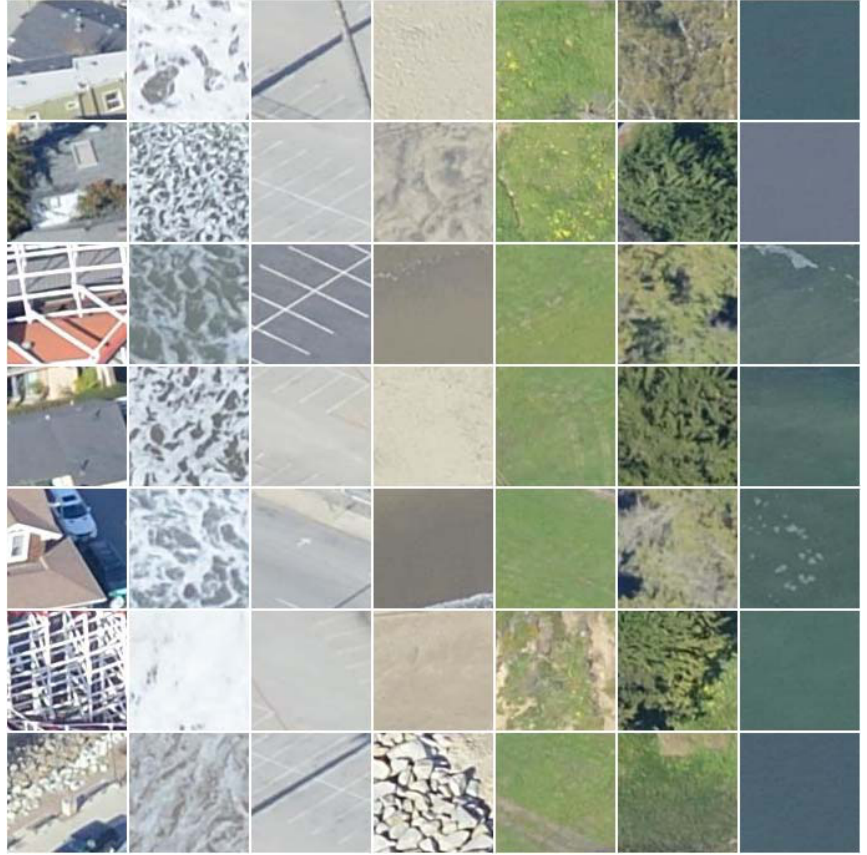
Figure 4. Example tiles from Seabright Beach. Classes, in columns, from left to right, are anthropogenic/buildings, foam, road/pavement, sand, other natural terrain, vegetation, and water.